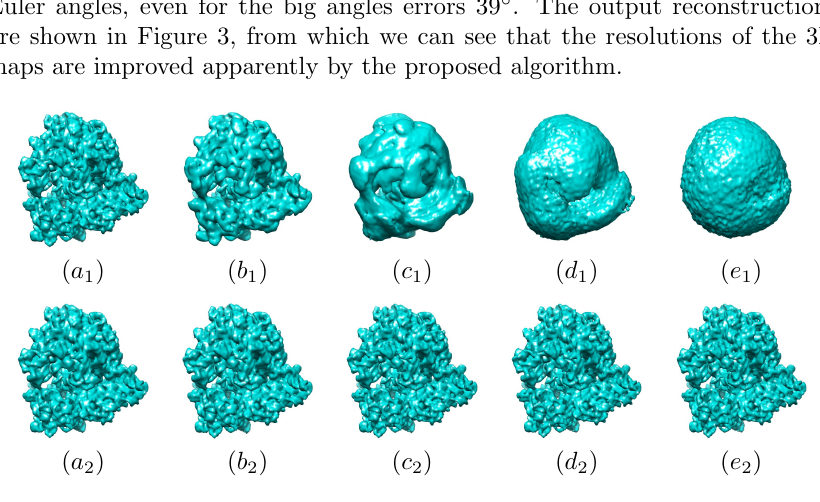
Figure 3. The comparisons of the initial maps (first row) and the refinement maps (second row) using the proposed algorithm. The maps from column (a) to column (e) show the cases for 1 ◦ , 3 ◦ , 9 ◦ , 21 ◦ and 39 ◦ respectively.